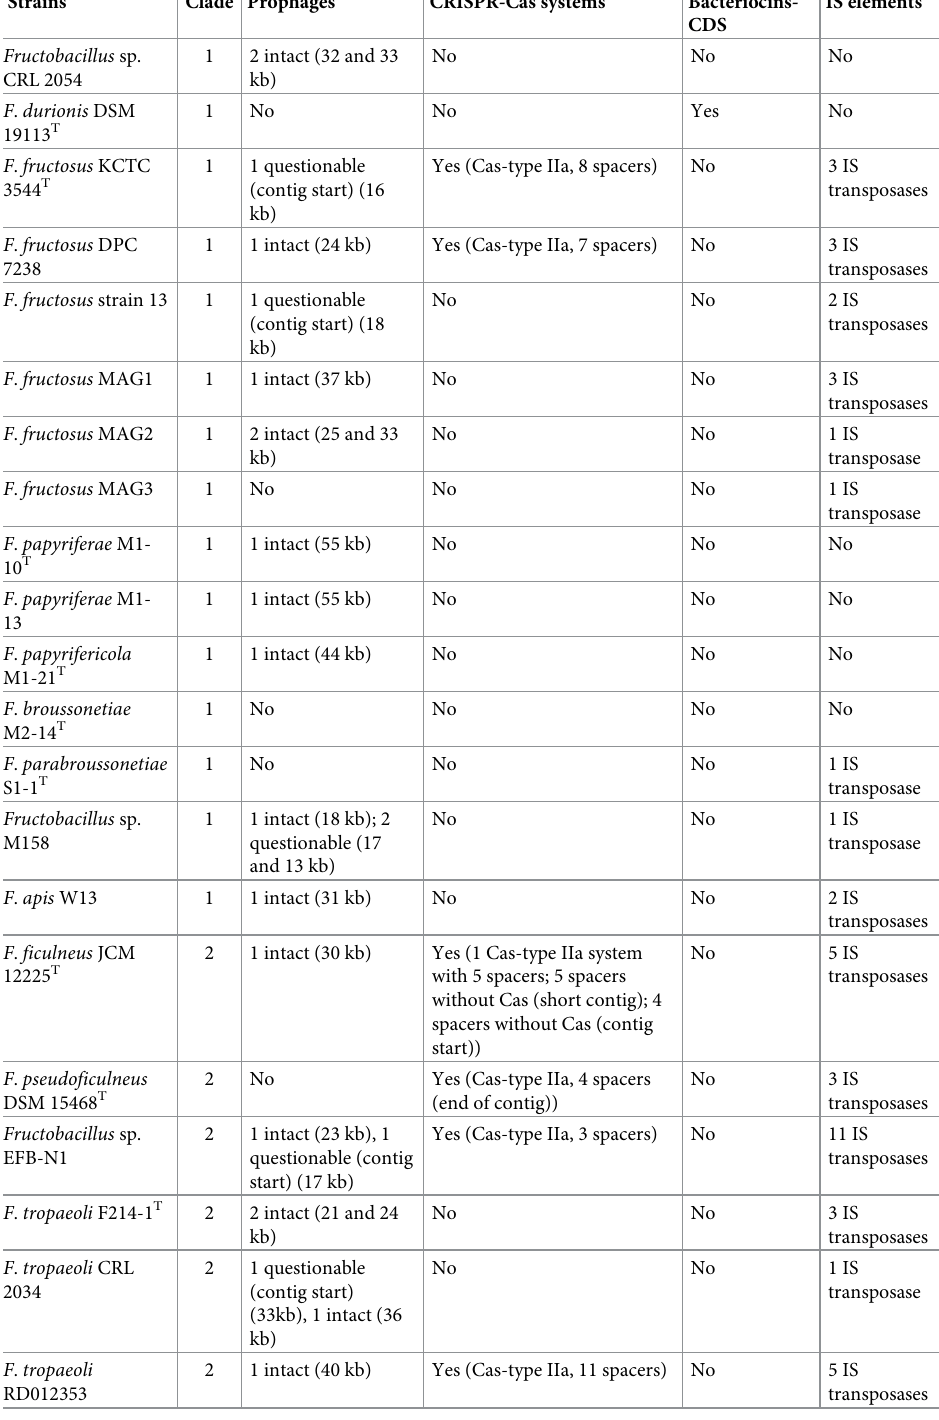
Table 2. Genomic regions related to horizontal transfer elements and antimicrobial properties found in Fructoba- cillus studied